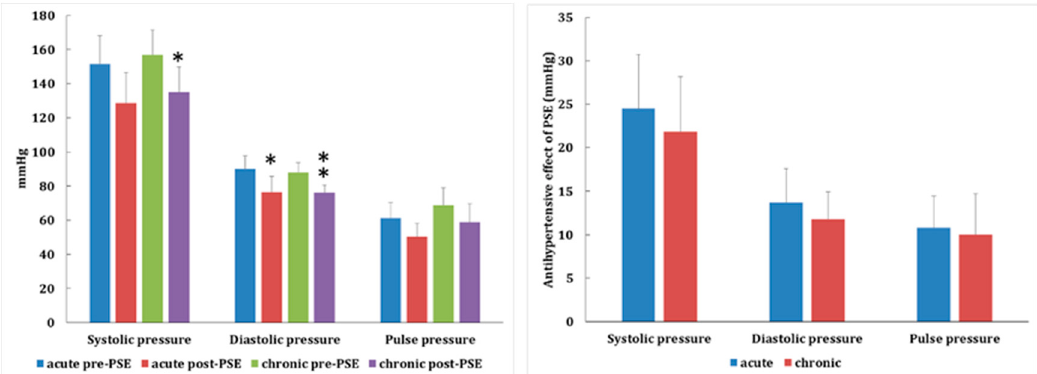
Figure 4. The one-time acute and chronic antihypertensive effects of Plantago asiatica seed extracts (PSEs, 360 mg/kg, p.o,, 4 weeks) on P1-HT rats ( n = 5). The antihypertensive effects after 4 weeks of 360 mg / kg, p.o., 4 weeks) on P1-HT rats ( n = 5). The antihypertensive e ff ects after 4 weeks of continuous continuous PSE oral administration were not significantly different from the first time PSE PSE oral administration were not significantly di ff erent from the first time PSE administration. This administration. This result showed that continuous oral administration did not negate the result showed that continuous oral administration did not negate the antihypertensive e ff ects of PSE treatment (* p < 0.05, ** p < antihypertensive effects of PSE treatment (* p < 0.05, ** p < 0.01).